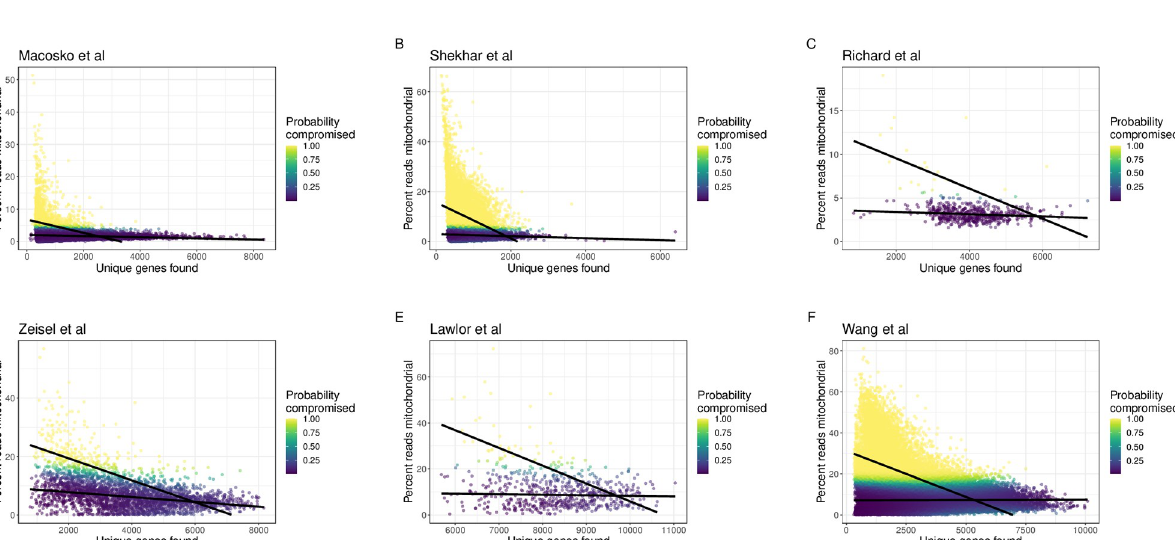
PLOS Computational Biology | https://doi.org/10.1371/journal.pcbi.1009290 August 24,